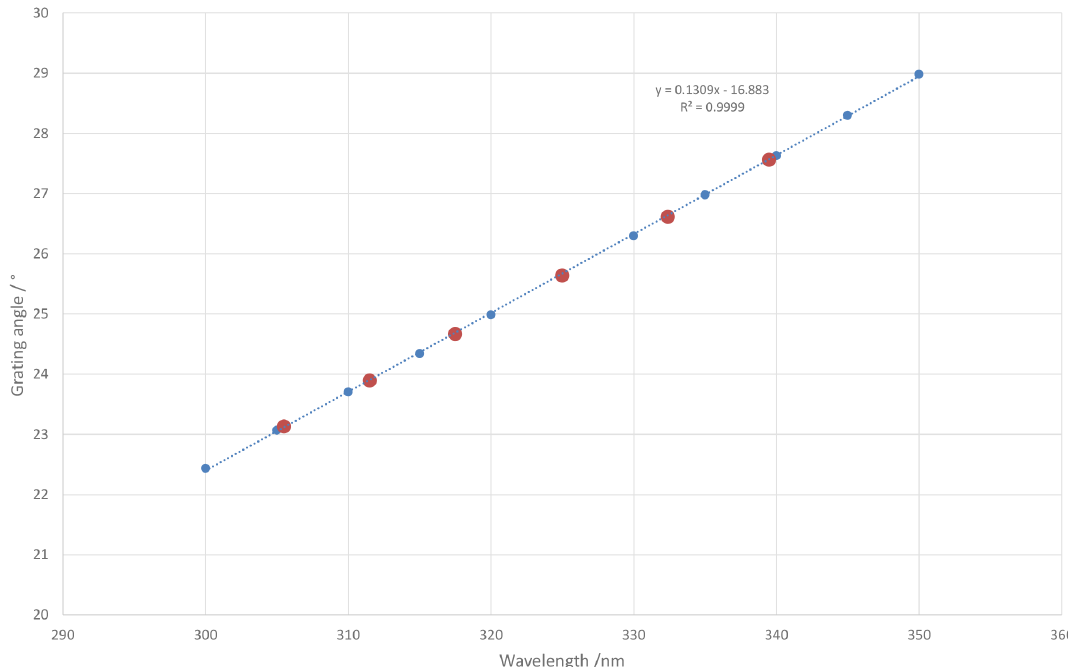
Figure 5. TuPS wavelength calibration function. Red points represent red values reported in Fig.